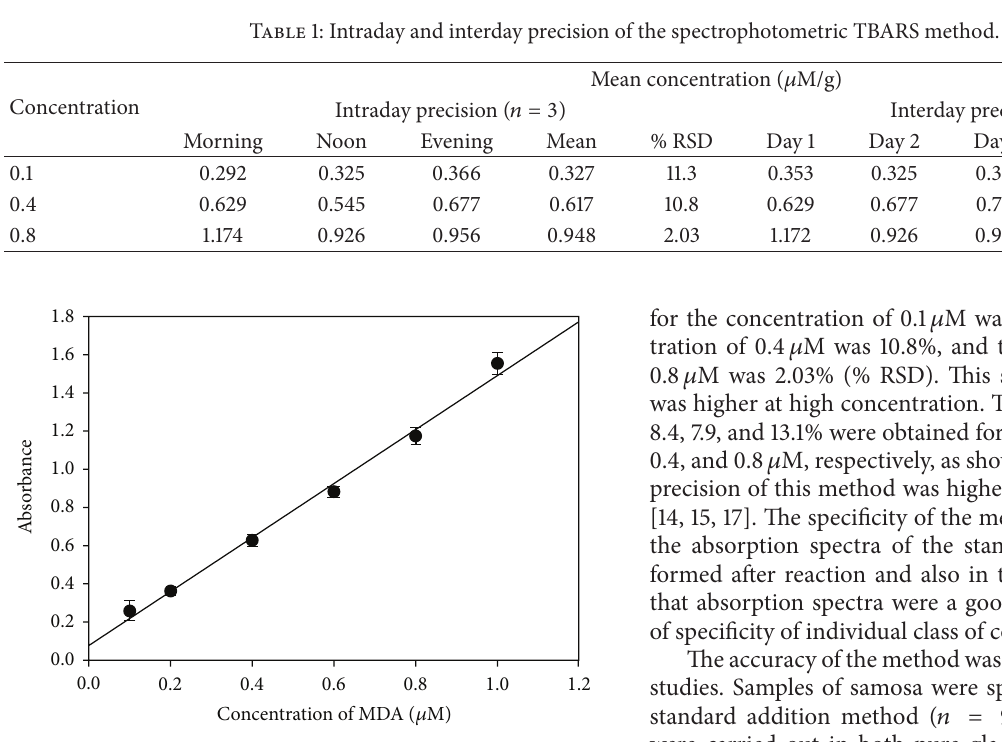
Figure 2: A linear regression curve of standard concentration of 0.1–1.0 𝜇 M with a correlation coefficient of 0.9929 and regression equation of 𝑦 = 1.4167𝑥 + 0.0785 . Each point in the regression represents the replicate measurement ( 𝑛 = 3